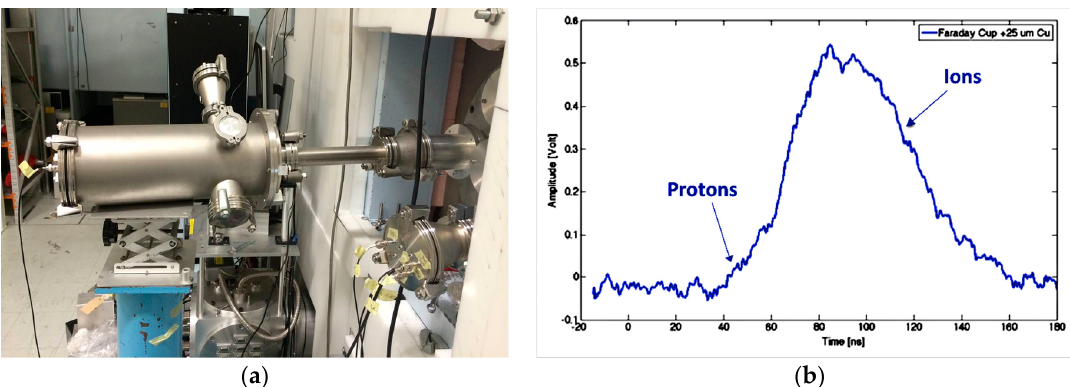
Figure 12. ( a ) Picture of the ELIMAIA FC installed in target chamber; ( b ) Ion signal acquired by the FC at about 3 m from the target.